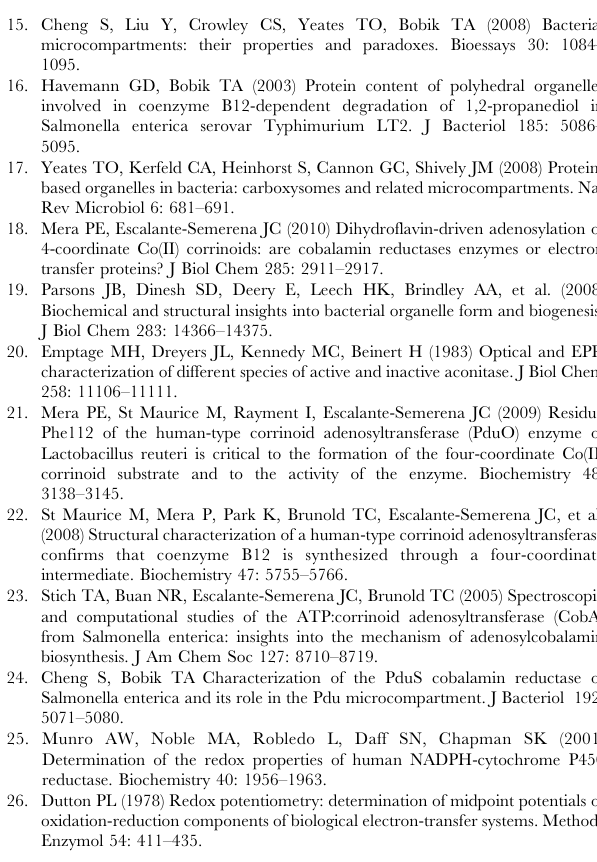
Found at: doi:10.1371/journal.pone.0014009.s001 (0.13